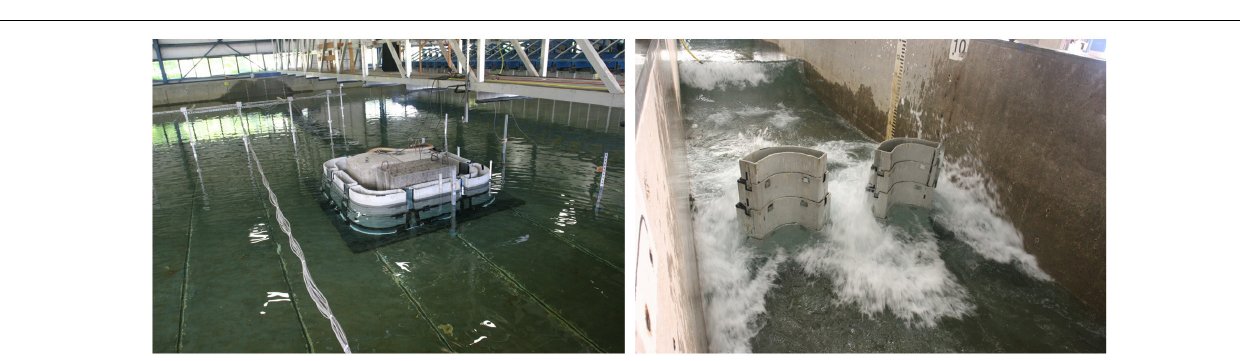
FIGURE 9 | Hydrostatic tests in DWB (left) and breaking wave tests in LWF (right)